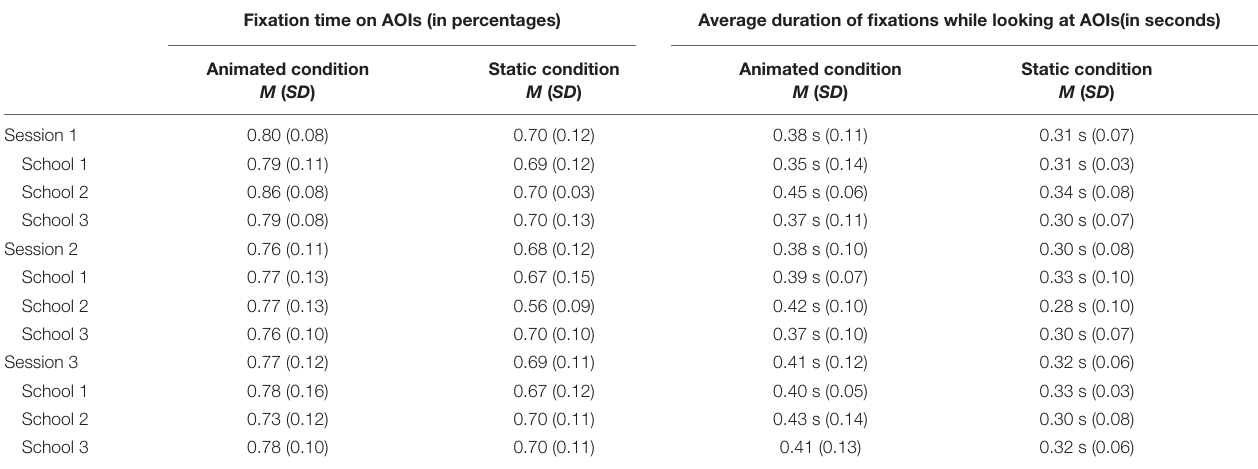
TABLE 4 | Visual attention to the salient movement depicting non-words in the animated and static condition per session. Fixation time on AOIs (in percentages) Average duration of fixations while looking at AOIs(in seconds) Animated condition M ( SD )